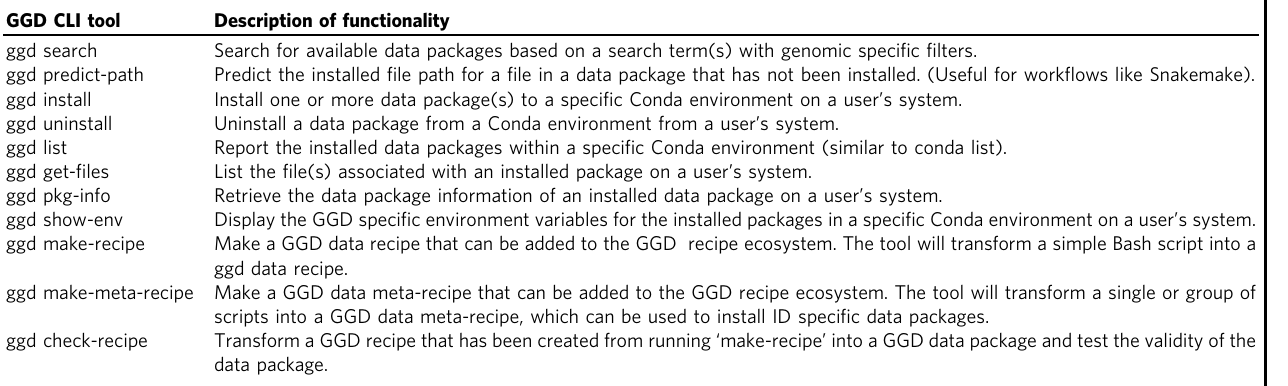
Table 1 A catalog of GGD tools available via the command-line